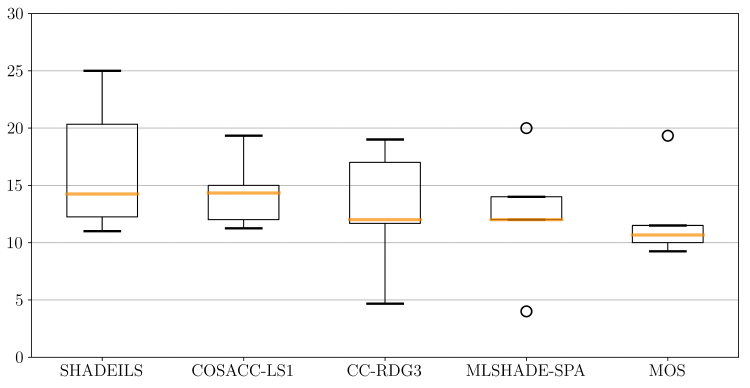
Figure 4. Variance of the adjusted